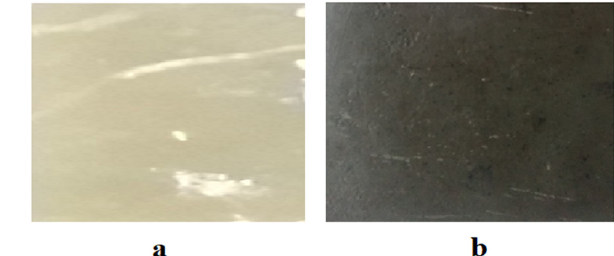
Figure 6: ( a ) Recycled EVA polymer without any leather waste fi ber content or neat recycled EVA polymer; ( b ) fabricated leather bu ffi ng dust/recycled EVA